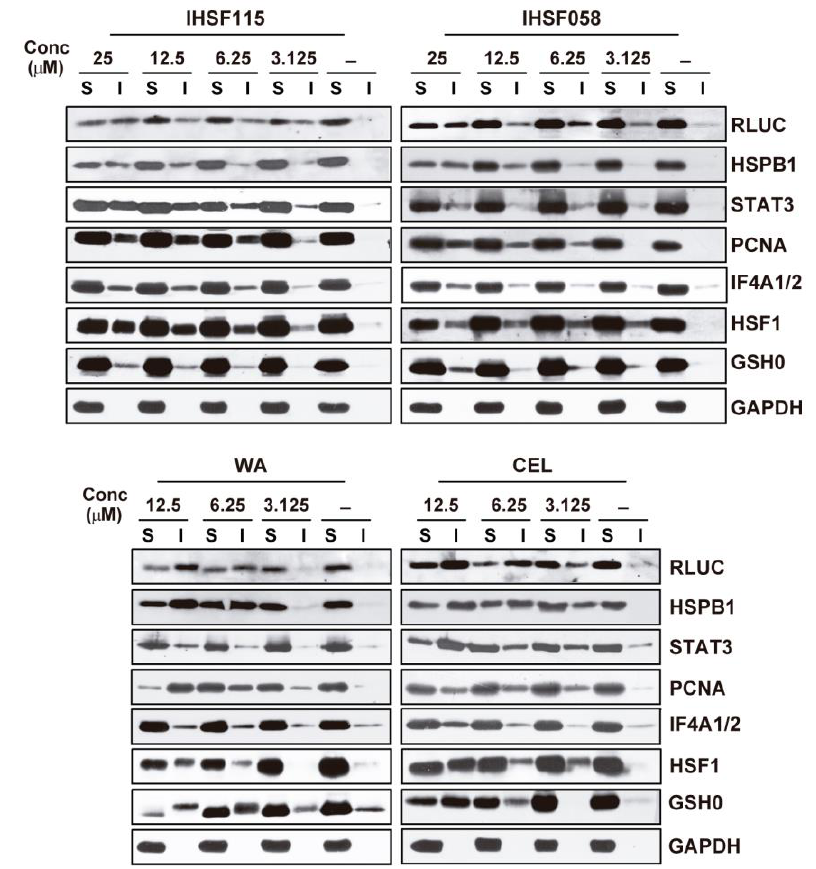
Figure 2. Denaturation of selected proteins in M1 cells exposed to increasing concentrations of IHSF115, IHSF058, CEL or WA. Parallel cultures of M1 cells exposed to compounds or vehicle (-)